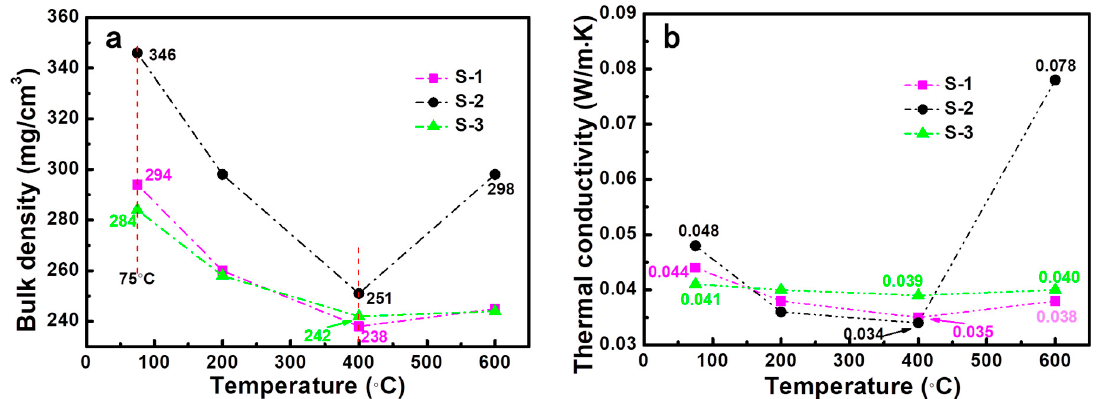
Figure 2. ( a ) Bulk density and ( b ) room-temperature thermal conductivity of silica aerogels before and after heat treatment at different temperatures.